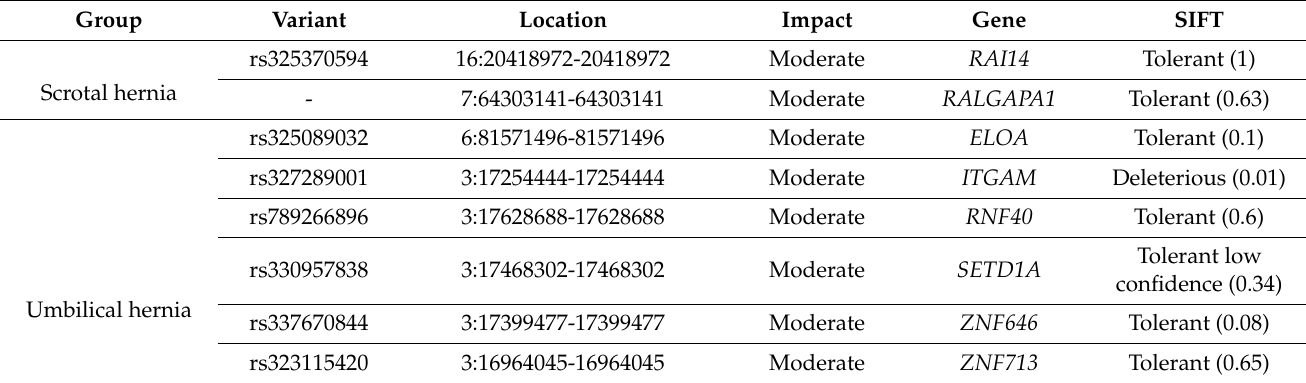
Table 7. Missense variants observed in groups with sorting intolerant from tolerant (SIFT) score calculated in the dbSNP database